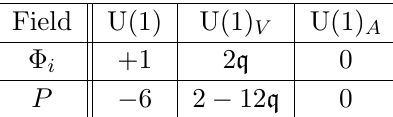
Table 1 . The U(1) gauge charge, U(1) V and U(1) A R-charge of matter (cid:12)elds P , (cid:8) i for i = 1 ; 2 : : : ; 6.